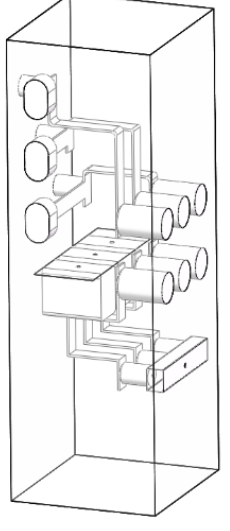
Figure 1. Model of Figure 1. Model of switchgear .